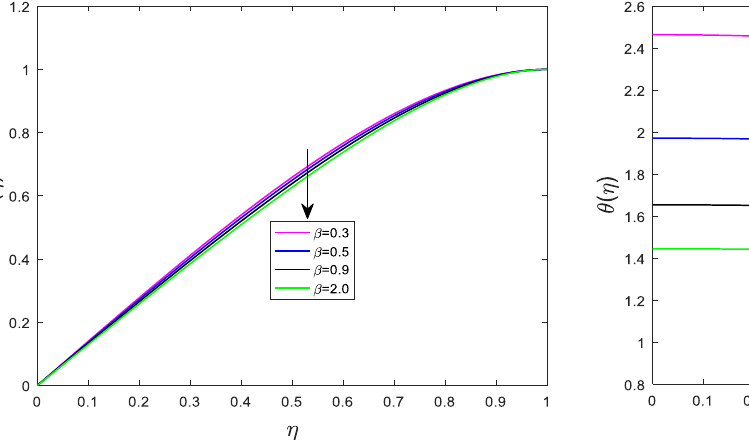
Figure 6: Effect of β on F ( η ) for fixed S = 6.0, Ha = Ω C = N t = Kr = 0.1, Ω = Ec = 0.5, N = 0.3, Pr = 1.5 and Sc = 0.7 b T